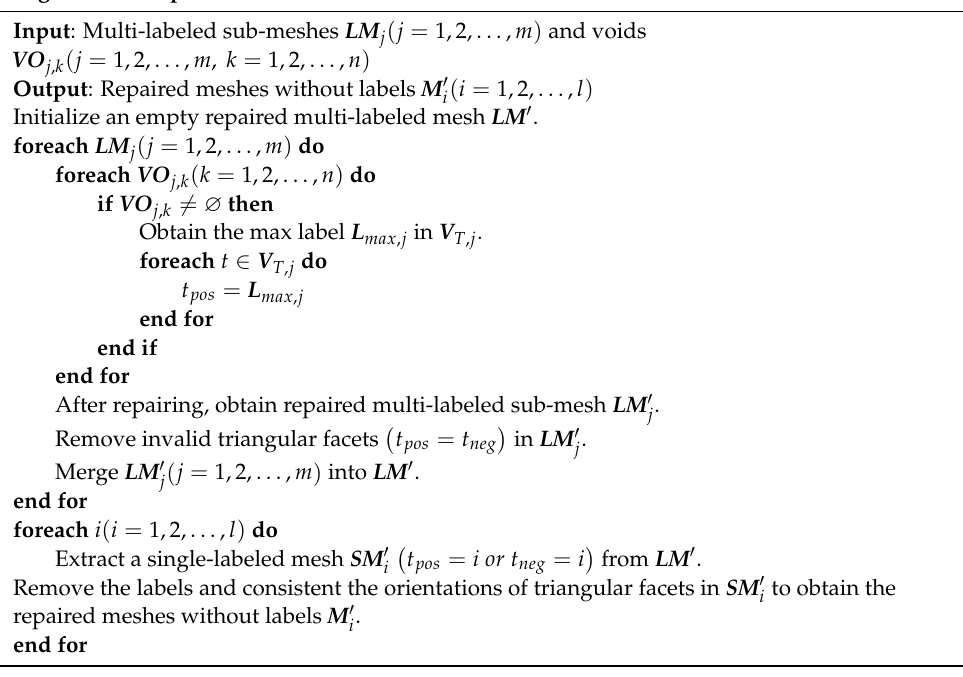
Algorithm 3 Repair voids.